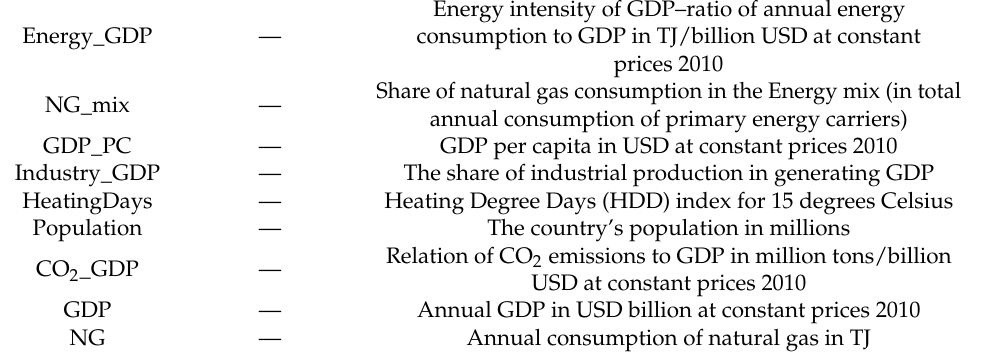
Table 1. Description of variables.